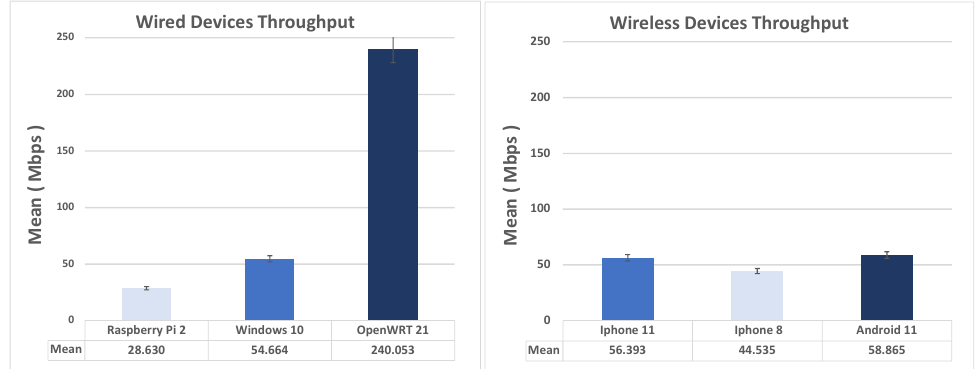
Figure 10. Comparison of the average Throughput in OpenConnect Road Warriors